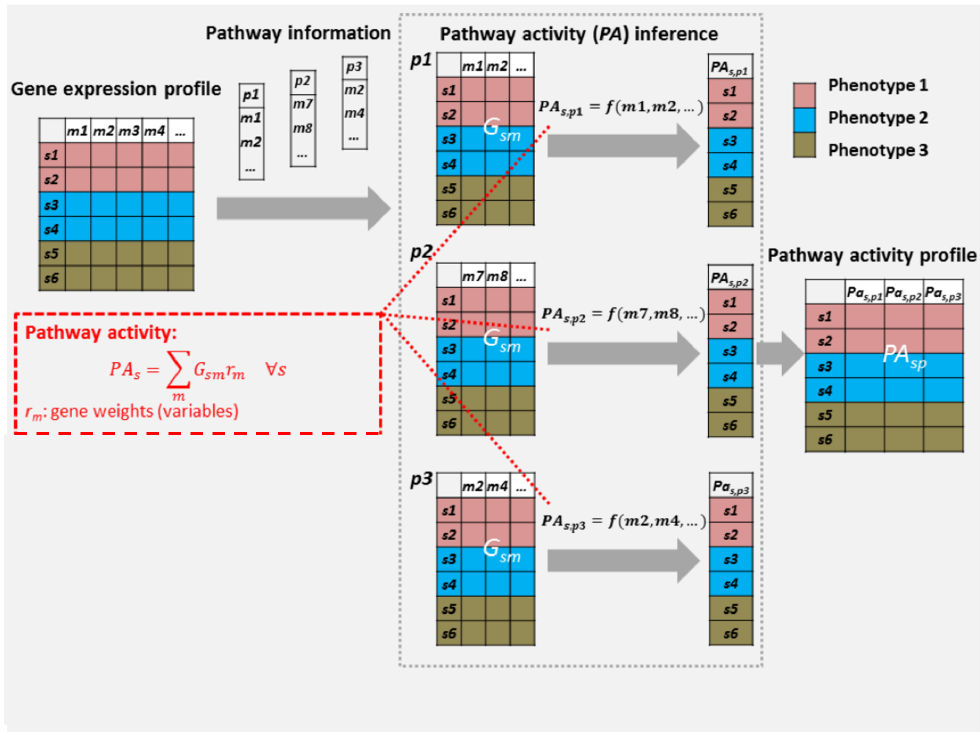
Figure 1. Pathway activity inference flowchart for DIOPTRA. The normalised RNA-Seq data and a number of pathway gene sets serve as the input to the pathway activity inference pipeline. For each pathway p , pathway activity values pa sp are calculated as linearly combined expressions of pathway genes G sm multiplied with gene weights r m , where r m is decided by two variables ( rp m and rn m ) in the model. A pathway activity profile is formed by connecting the pathway activity vectors of all pathways, and the new matrix of pathway activity profiles is obtained and further